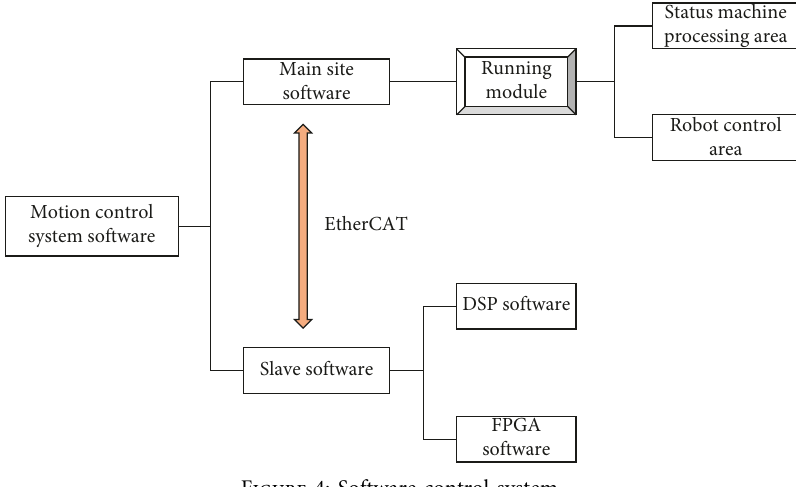
Figure 4: Software control system.